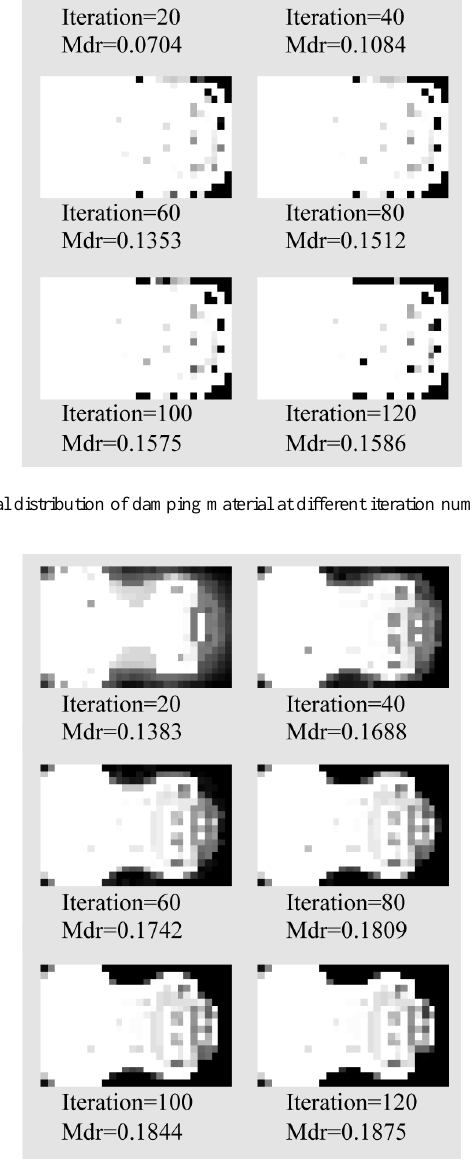
Fig. 6. Optimal distribution of damping material at different iteration numbers, vf =